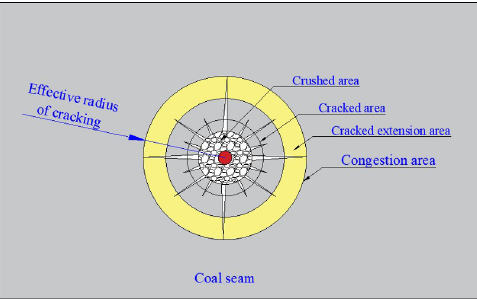
Fig 4. Schematic diagram of the effective radius of phase change fracturing of liquid CO 2 .